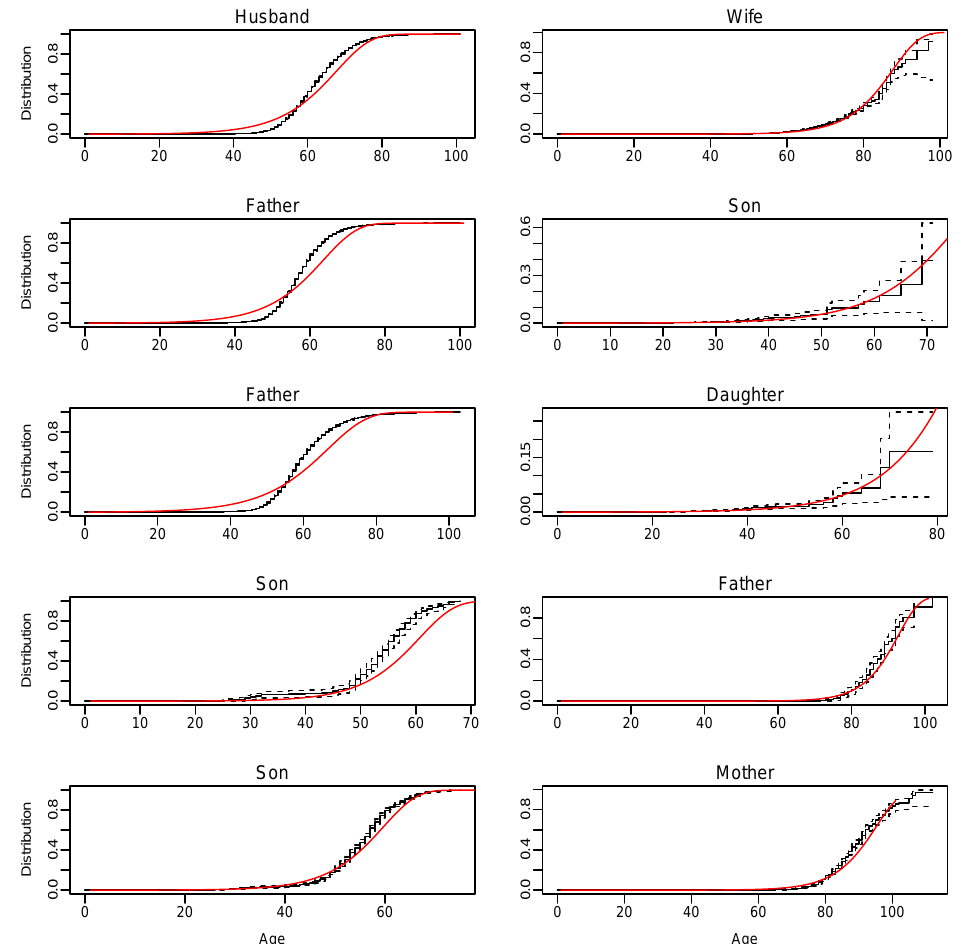
Figure 2. Comparison of Kaplan-Meier marginal distribution functions with 95% confidence intervals (black) and Gompertz marginal distribution functions with MCMC marginal parameter estimates as in Table 5